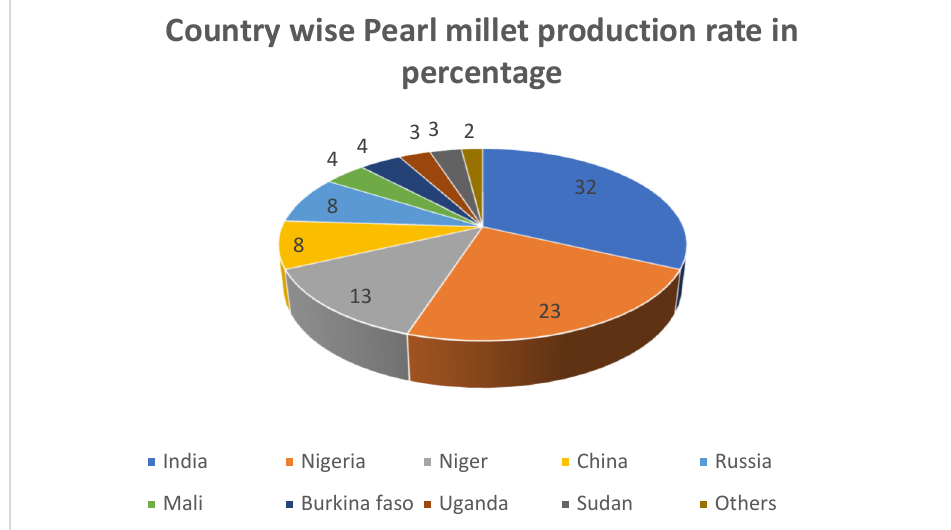
Figure 1. Pearl millet production rate (in percentages) of different countries